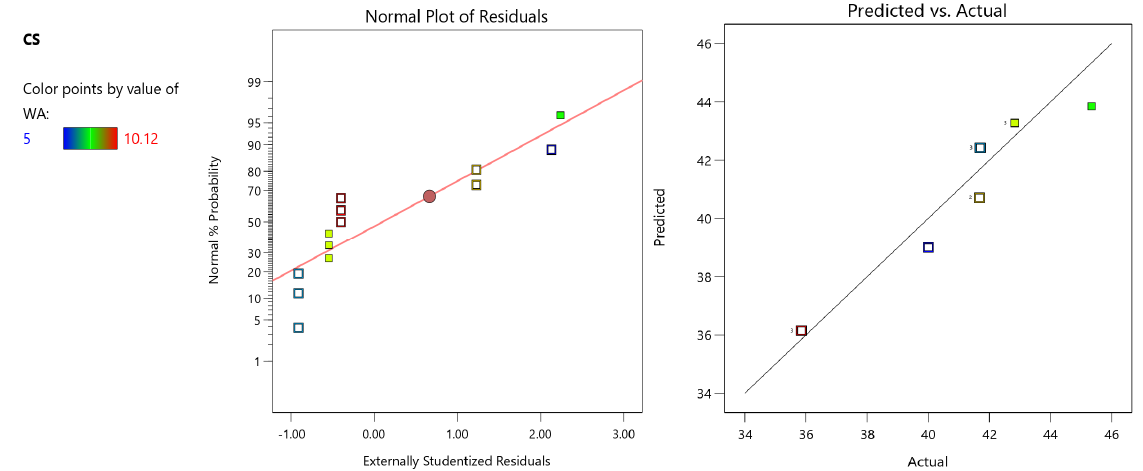
Figure 15. Normal plot for residuals, and actual vs. predicted values for compressive strength.